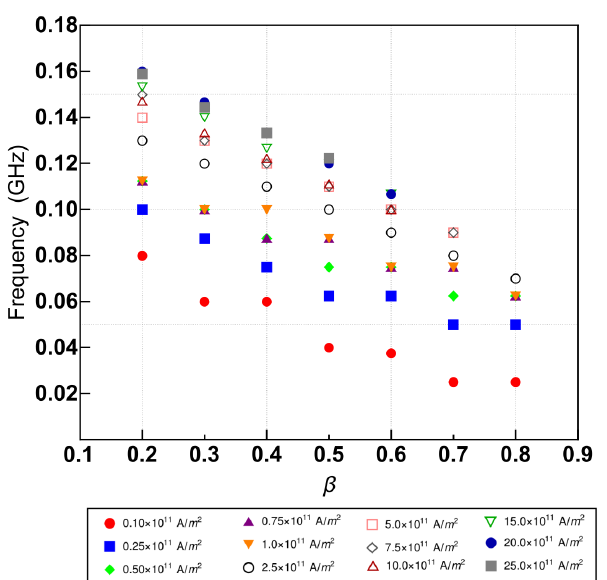
Figure 7. Value of frequency where the FFT is at its maximum as a function of β for different values of J